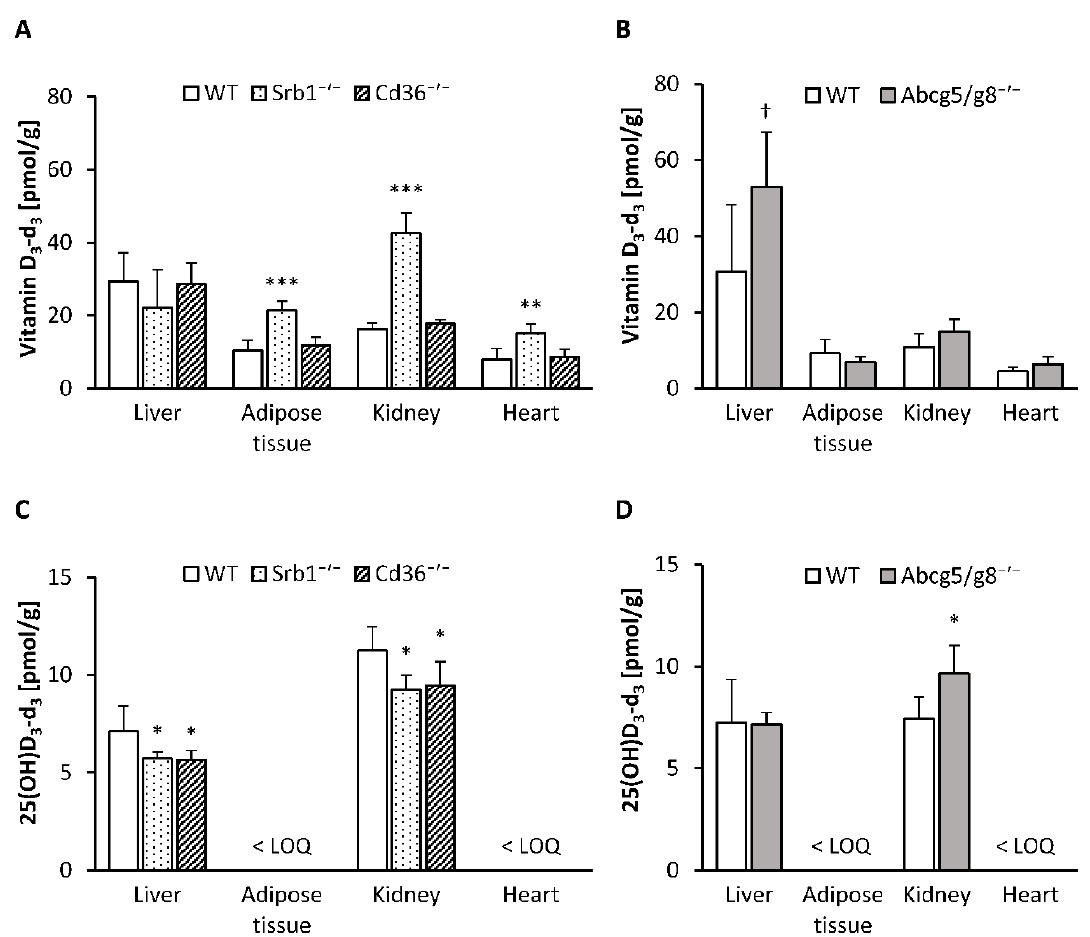
Figure 2. Concentrations of vitamin D 3 -d 3 in the liver, retroperitoneal adipose tissue, kidney and heart of Srb1 -/- and Cd36 -/- mice versus corresponding wild-type (WT) mice ( A ), and Abcg5/g8 -/- mice versus corresponding WT mice ( B ). Concentrations of 25(OH)D 3 -d 3 in the liver, retroperitoneal adipose tissue, kidney and heart of Srb1 -/- and Cd36 -/- mice versus corresponding WT mice ( C ), and Abcg5/g8 -/- mice versus corresponding WT mice ( D ). All mice were fed diets containing 25 µg/kg triple- deuterated vitamin D 3 (vitamin D 3 -d 3 ) for six weeks. Data are presented as the means ± SD, n = 5–7; *** p < 0.001, ** p < 0.01, * p < 0.05, † p < 0.1 (compared to the corresponding WT mice, Student’s t test). The limit of quantification (LOQ) of 25(OH)D 3 -d 3 was 3.0 pmol/g for the retroperitoneal adipose tissue and 3.2 pmol/g for the heart. 25(OH)D 3 -d 3 , triple-deuterated 25-hydroxyvitamin D 3 ; Abcg5/g8 -/- , ATP- binding cassette transporters G5/G8 knockout mice; Cd36 -/- , cluster determinant 36 knockout mice; Srb1 -/- , scavenger receptor class B type 1 knockout mice.